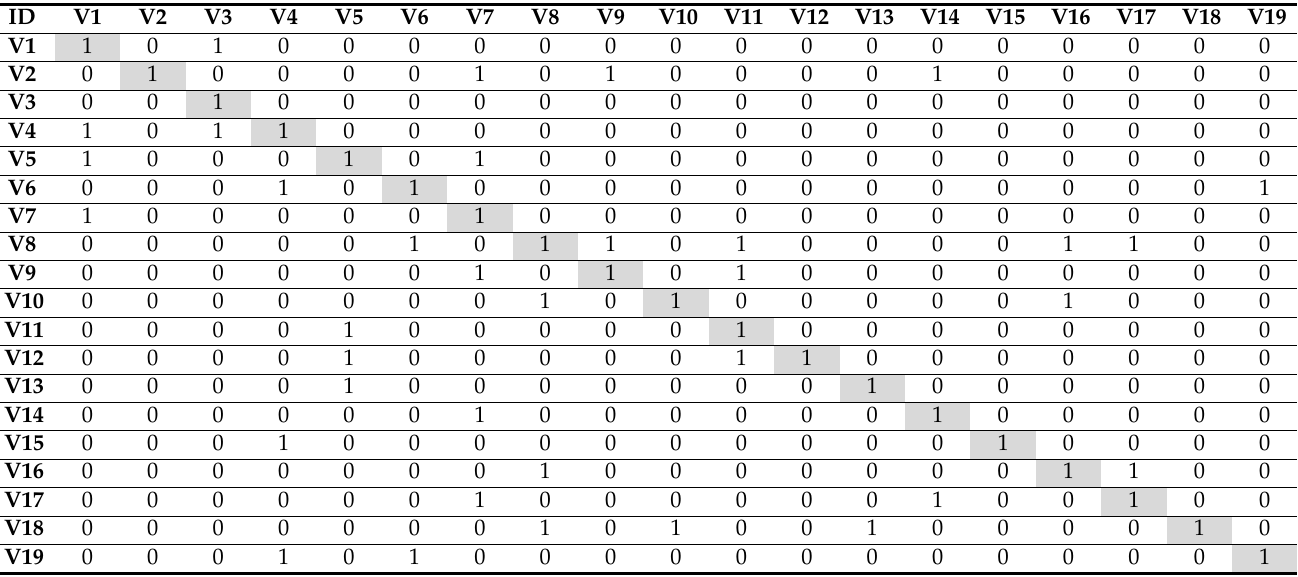
Table 2. Initial reachability matrix